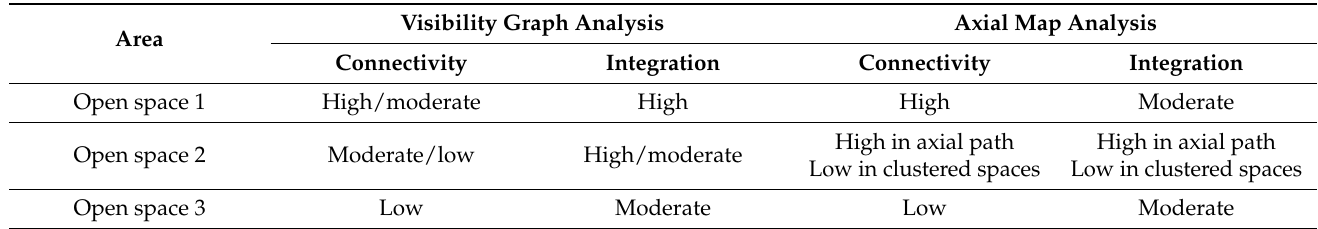
Table 5. Summary of the major space syntax findings for the three open spaces.